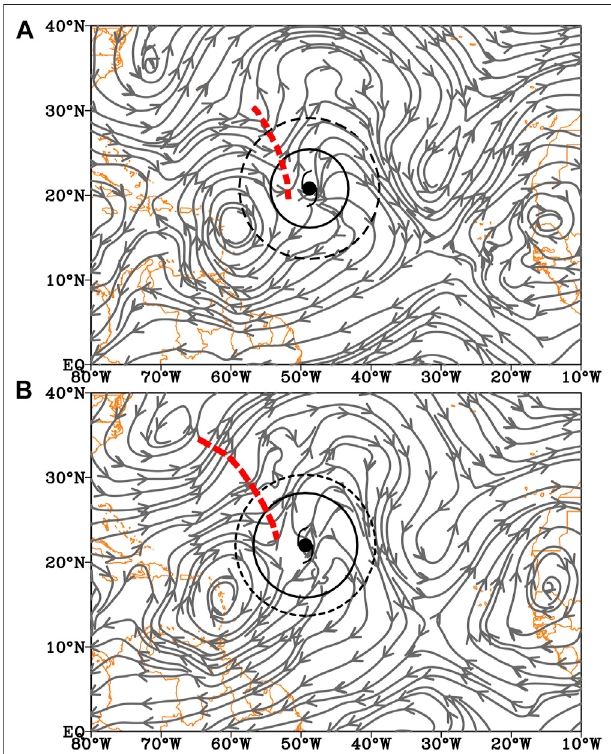
FIGURE 13 | As in Figure 11 but for the RI period at (A) 1800 UTC 17 and (B) 0600UTCSep. 18, 2006.The black solidcircle indicates theradius of theouterclosedisobar(ROCI)of556and740 kmfor (A) and (B) ,respectively. The black dashed circle denotes R (cid:2) 1,000 km. The red dashed lines denote the westerly